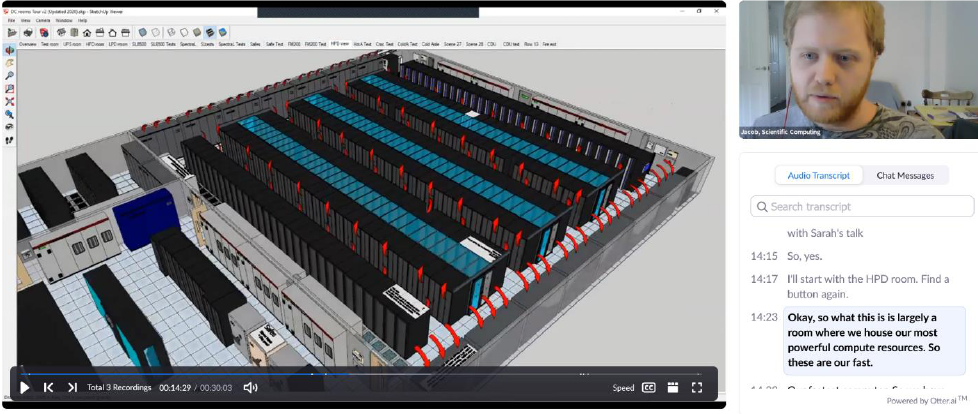
Fig. 4. A virtual data centre tour in